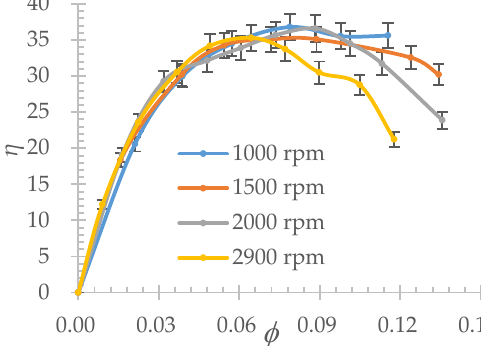
Figure 8. Global efficiency versus flow coefficient for several rotational speeds.